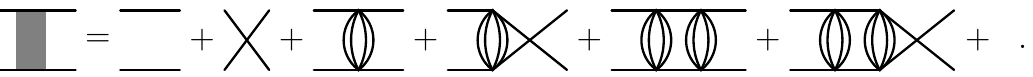
Figure 10. The full forward four-point function as a series of ladders. The crossings should be omitted for our rank-3 model, because it is built on complex (cid:12)elds, with bipartite graphs. However, they contribute for the rank-5 model, which has real